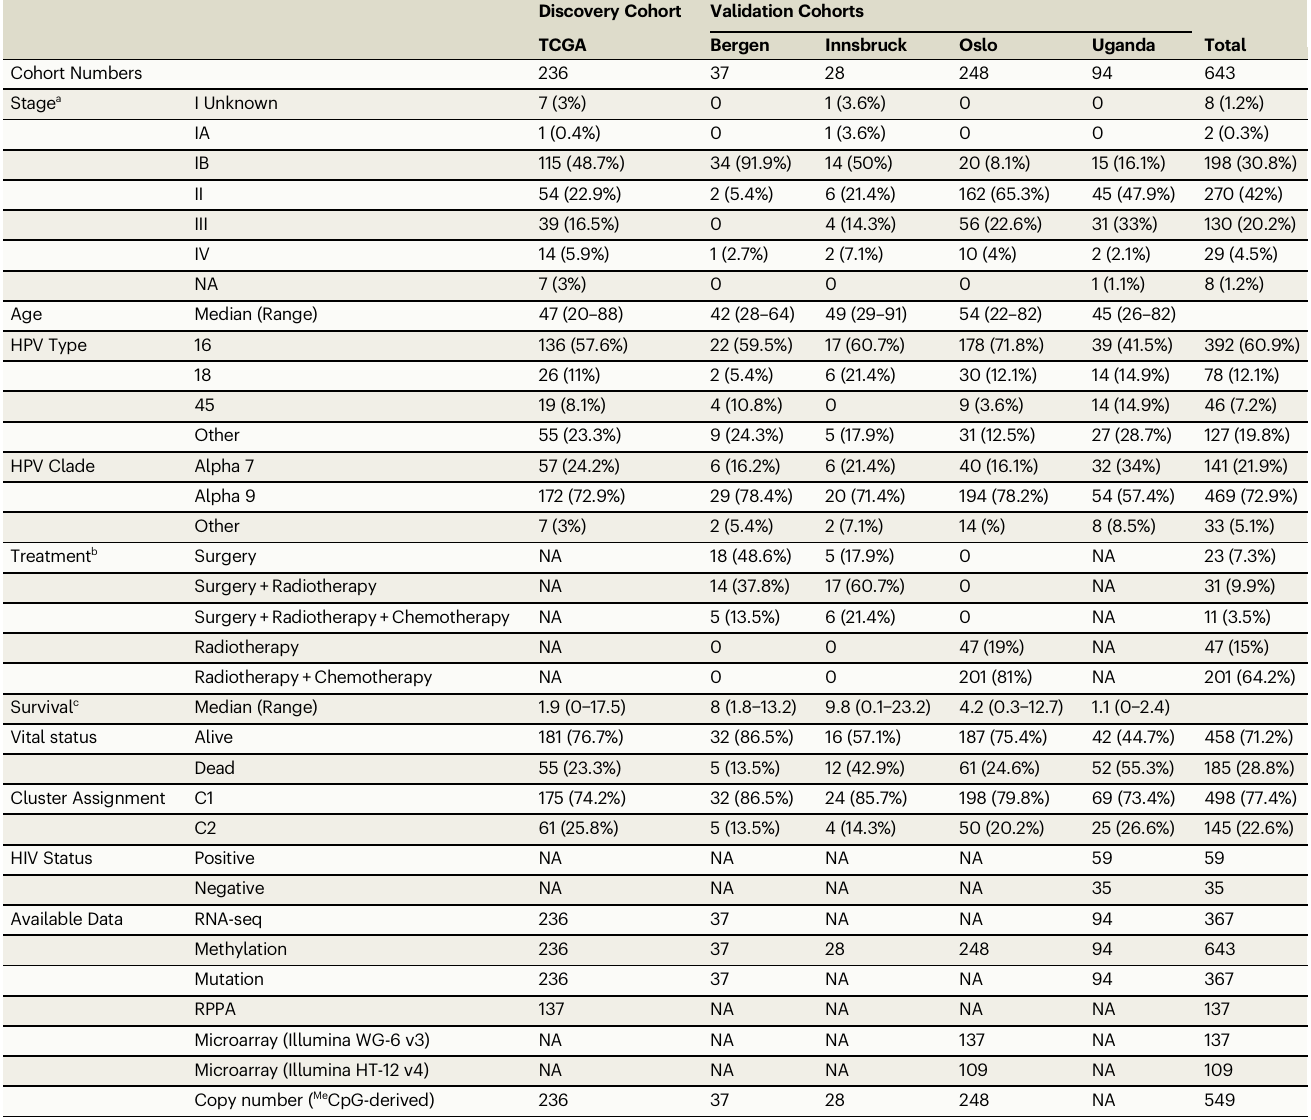
Table 1 | Summary of clinicopathological characteristics for fi ve cervical cancer